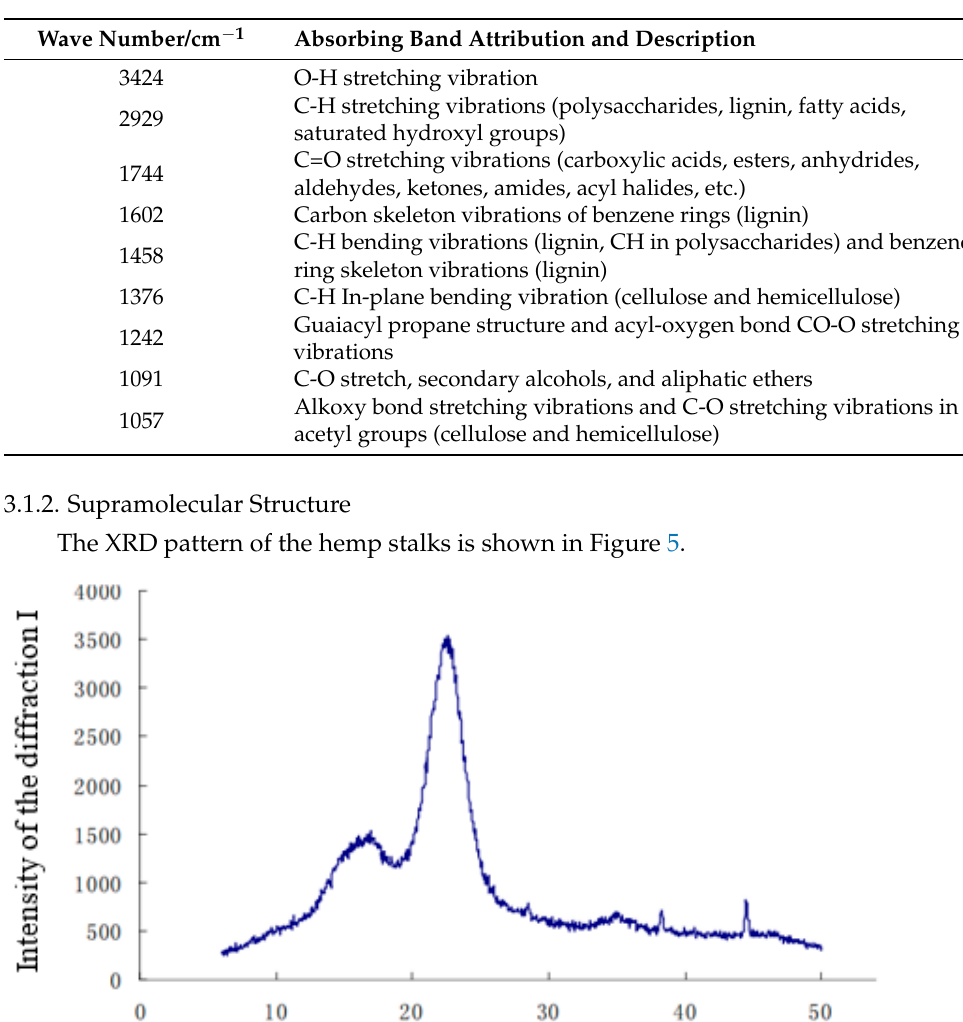
Table 2. Attribution of absorption bands in the FTIR spectrum of a hemp stalk.